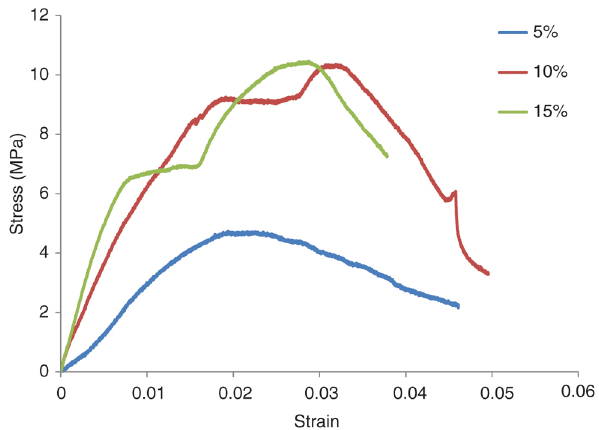
Figure 10: Stress-strain curve for samples prepared at 70°C temperature and 70 bar pressure with epoxy coating.